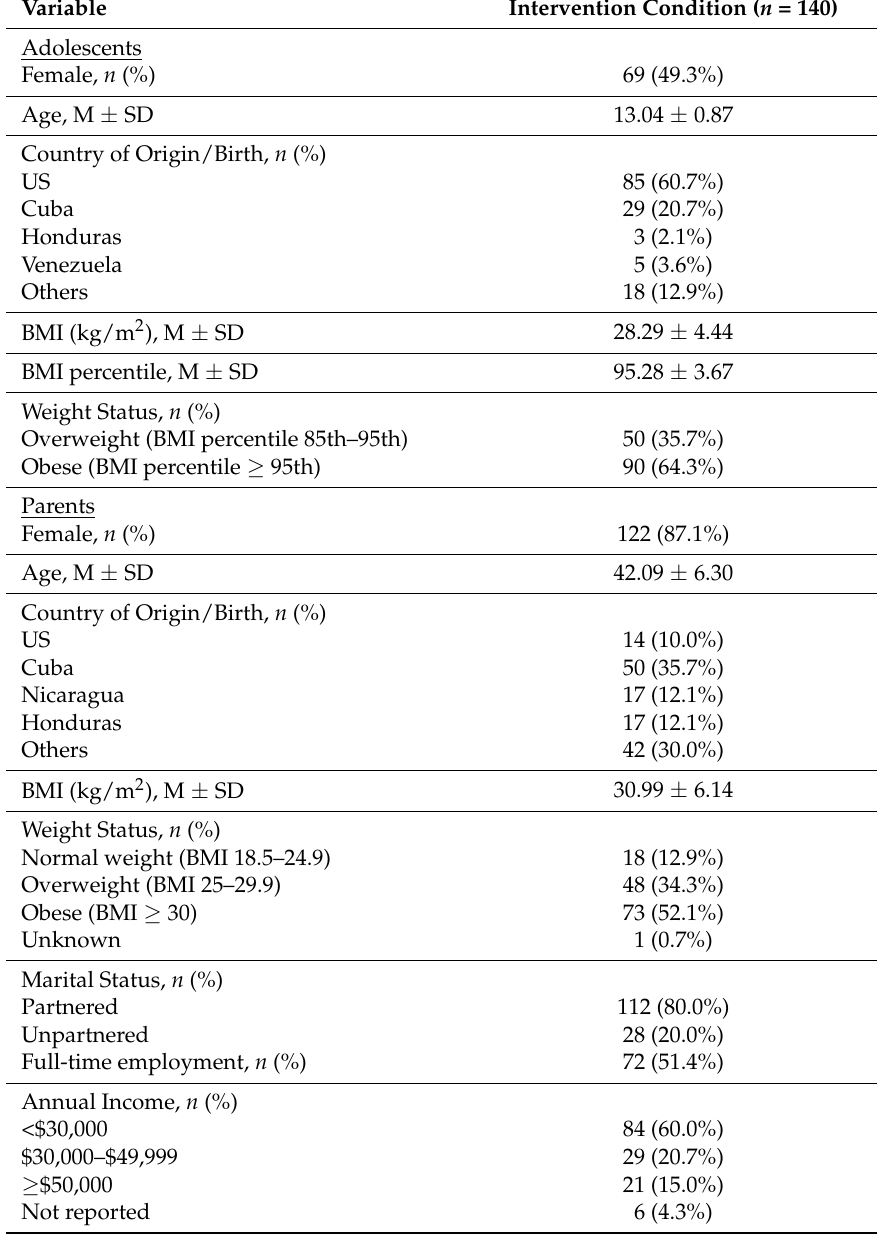
Table 1. Participant Demographic Characteristics at